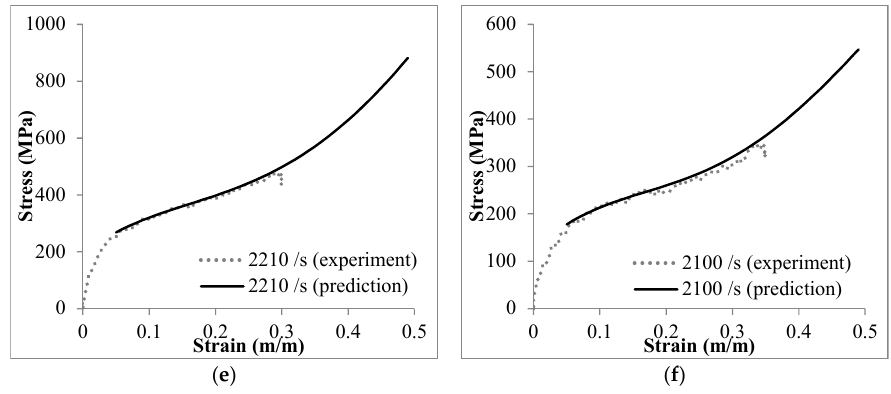
Figure 15. Comparison between the experimental and prediction results of: ( a , c , e ) Invar ‐ 5CS; and ( b , d , f ) Invar ‐ 10CS at different strain rates.